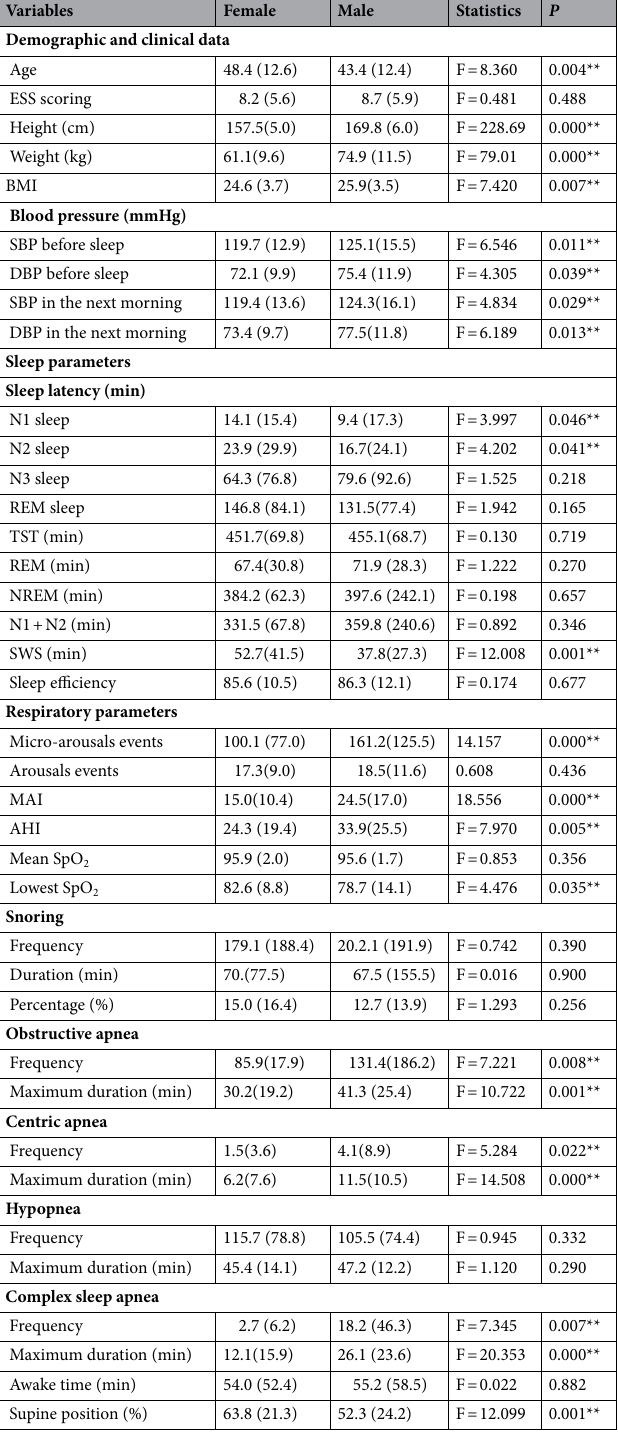
Table 3. Univariate logistic regression analysis of gender differences of clinical and polysomnographic findings with OSAS. MAI microarousal index, AHI apnea–hypopnea index, SWS slow wave sleep, TST